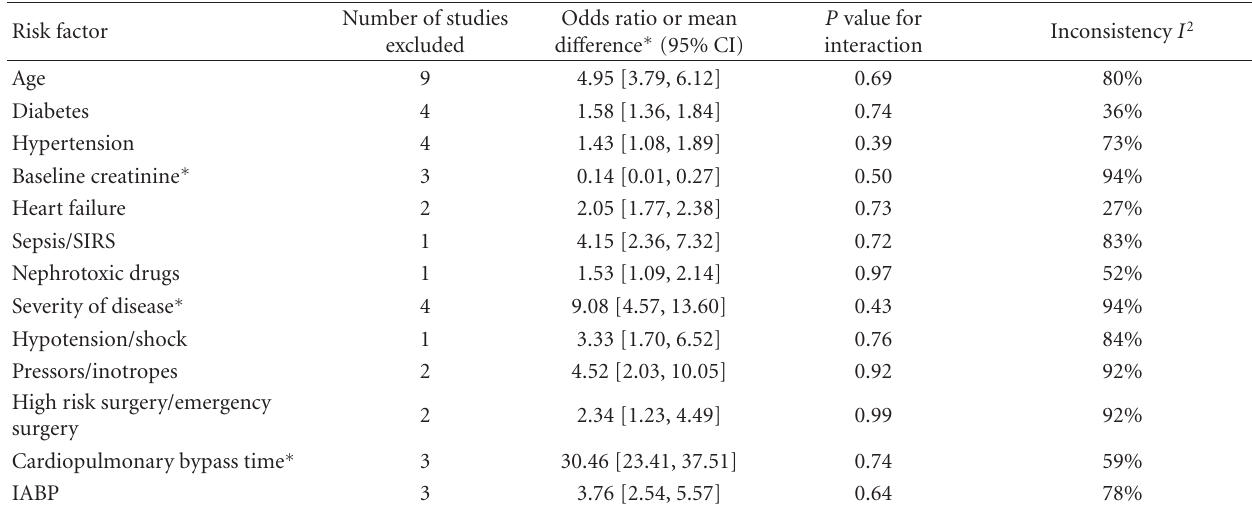
Table 5: Sensitivity